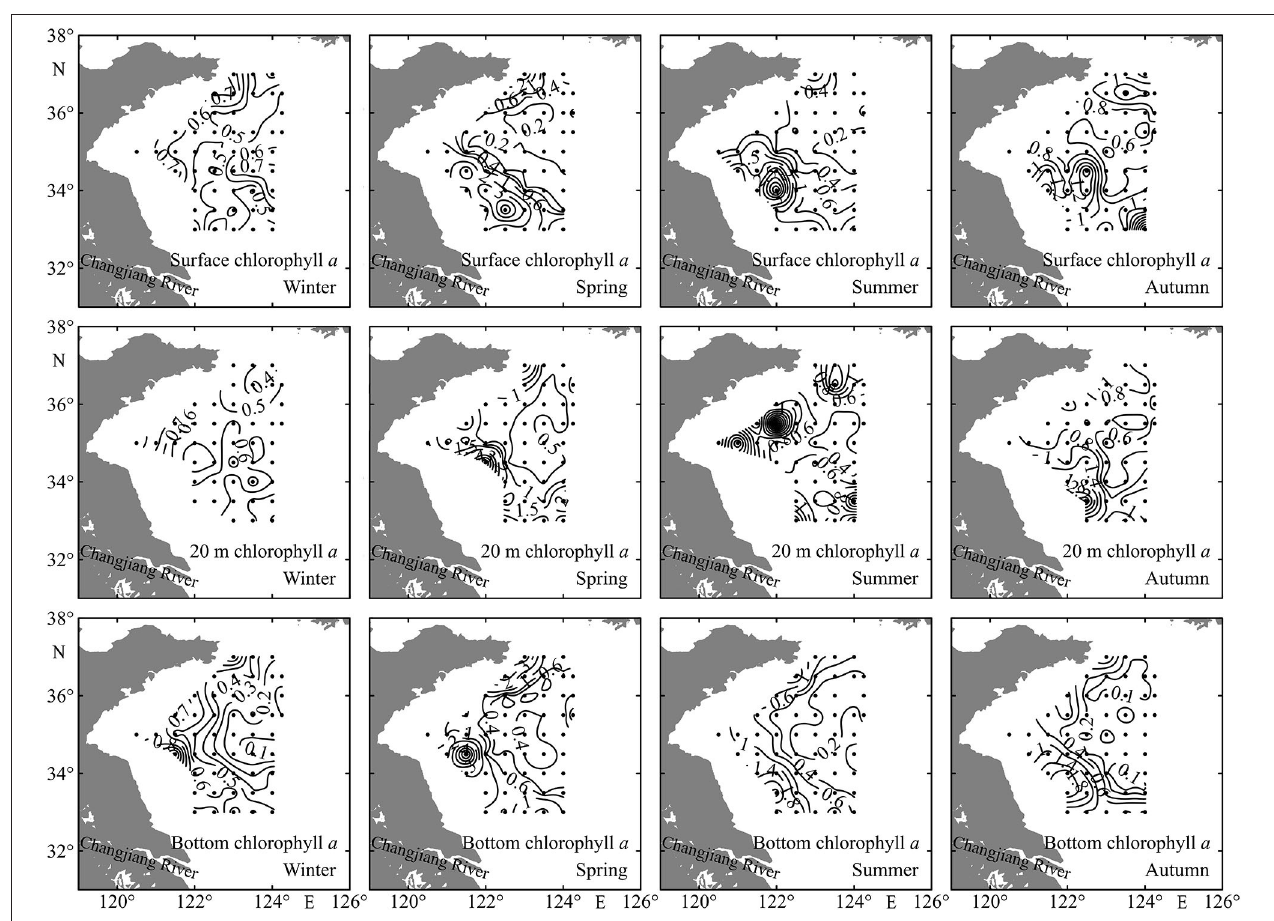
FIGURE 4 | Spatial distributions of sea surface, 20m depth, and bottom chlorophyll a concentrations (mg m − 3 ) in the Yellow Sea during four seasons.